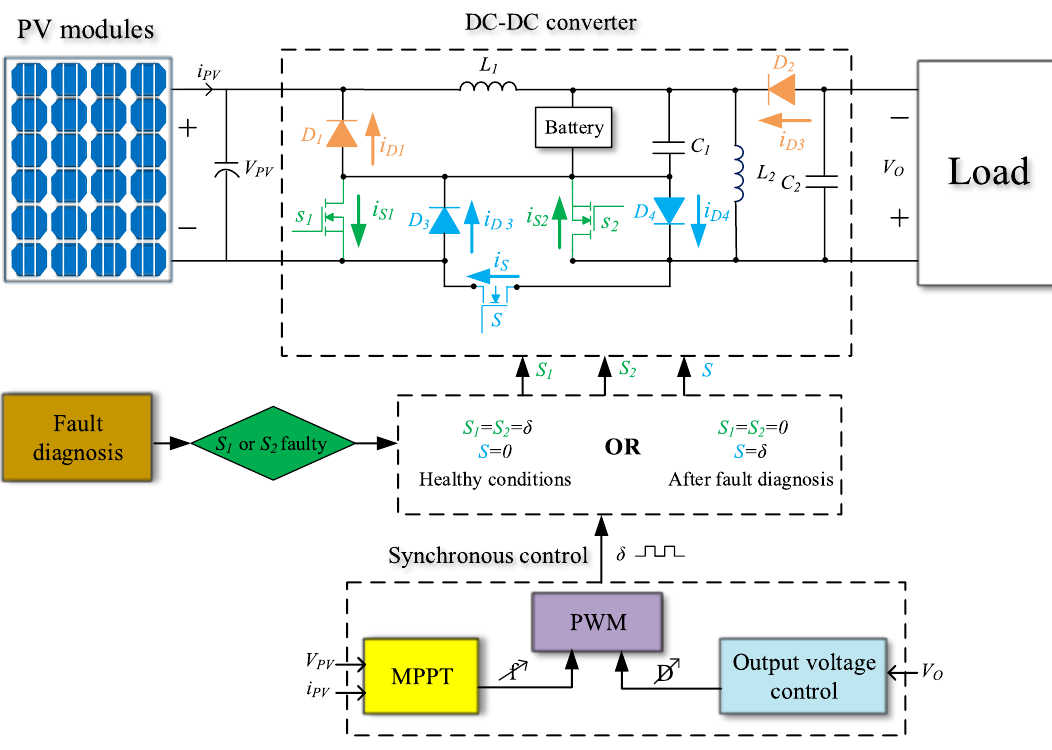
Figure 7. PV system with service continuity